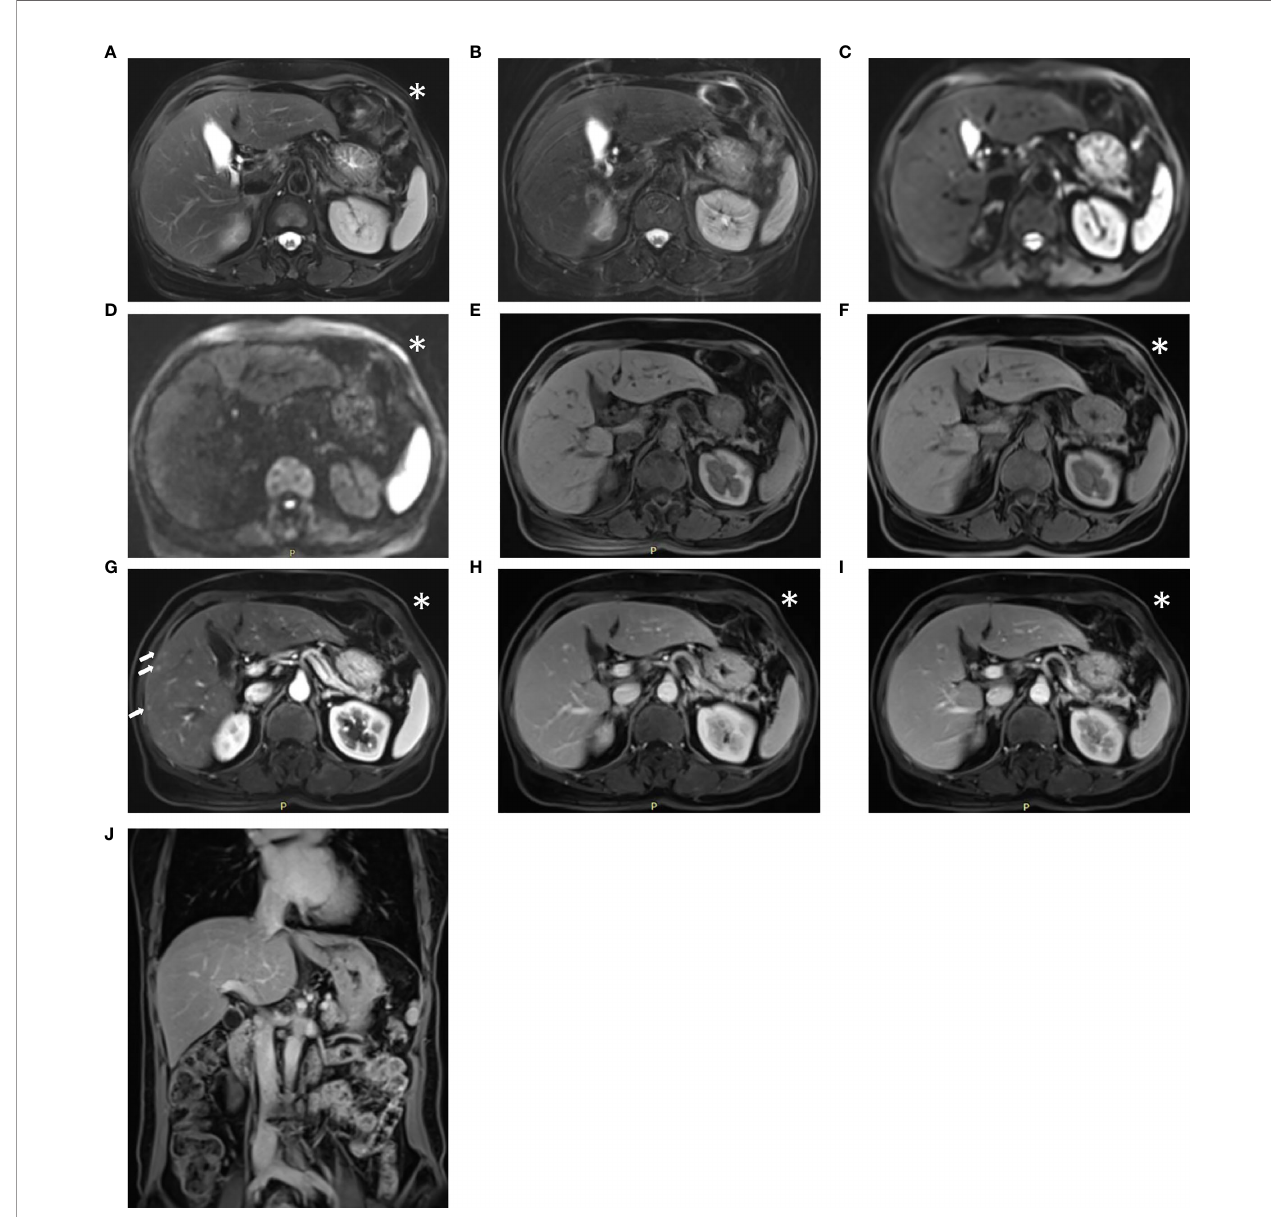
FIGURE 3 | Sample images acquired with the conventional liver work fl ow of a 52-year-old post-surgical colon cancer patient. The lesion could not be identi fi ed on the T2-weighted BLADE image (A) , T2-weighted TSE image (B) , DW images with b = 50, 1000 s/mm 2 (C, D) , pre-contrast T1-weighted Fat-Sat VIBE images (E) , or water images of the DIXON VIBE (F) . In the arterial phase T1-weighted VIBE (G) , multiple small hypervascular focal lesions appear in the right lobe. The suspicious lesions return to isointensity on the venous-phase (H) and delayed-phases (I, J) . The diagnostic report from the conventional protocol considered them as transient hepatic intensity difference, whereas in the report from the abbreviated protocol, these suspicious lesions were not mentioned. The abbreviated protocol acquired the image marked with an asterisk (*), whereas the conventional protocol acquired all the series. Notably, the suspicious transient hepatic intensity difference is subtle and dif fi cult to